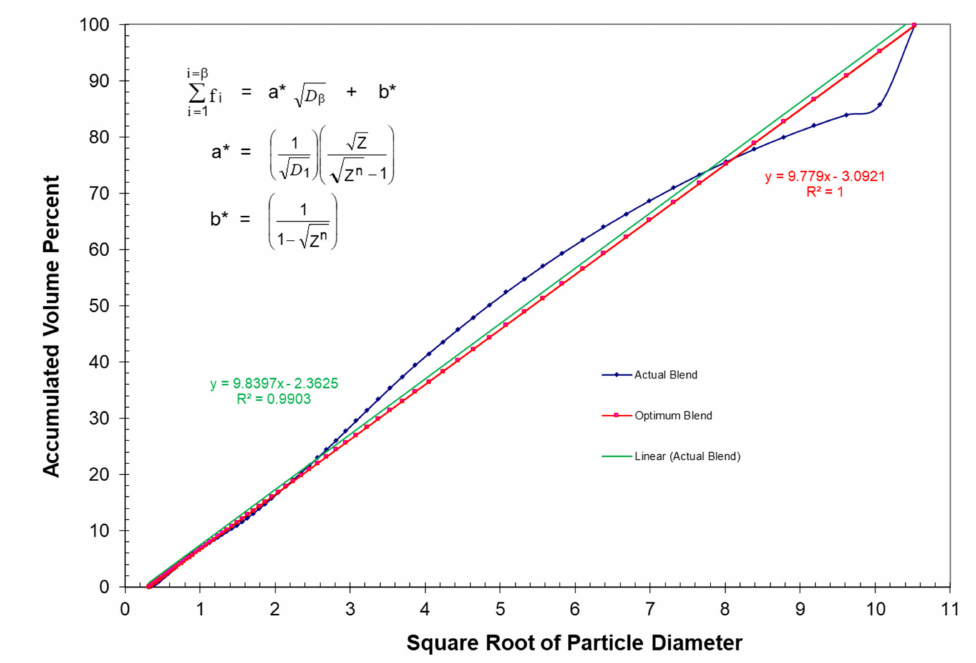
Figure 16. Accumulated volume percent vs. square root of particle diameter for an actual blend of three particle size distributions to the straight line